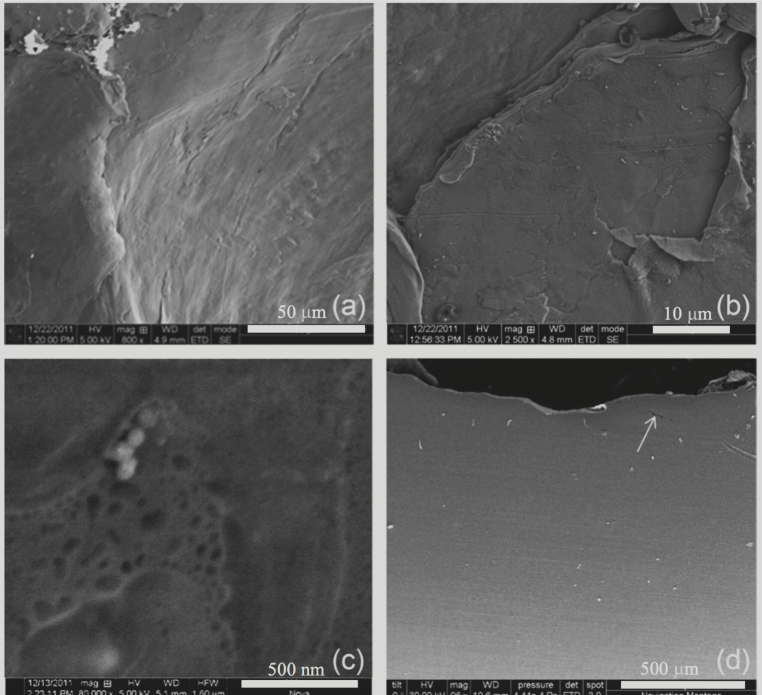
Figure 11. SEM micrographs of the 1100-O aluminum shock compressed to 9 GPa showing ( a ) inter- granular spall fracture surface, ( b ) an enlarged view of the intergranular spall fracture surface with tongues, ( c ) nanovoids in isolated areas of the fracture surface, and ( d ) the cross-sectional view of the fractured sample